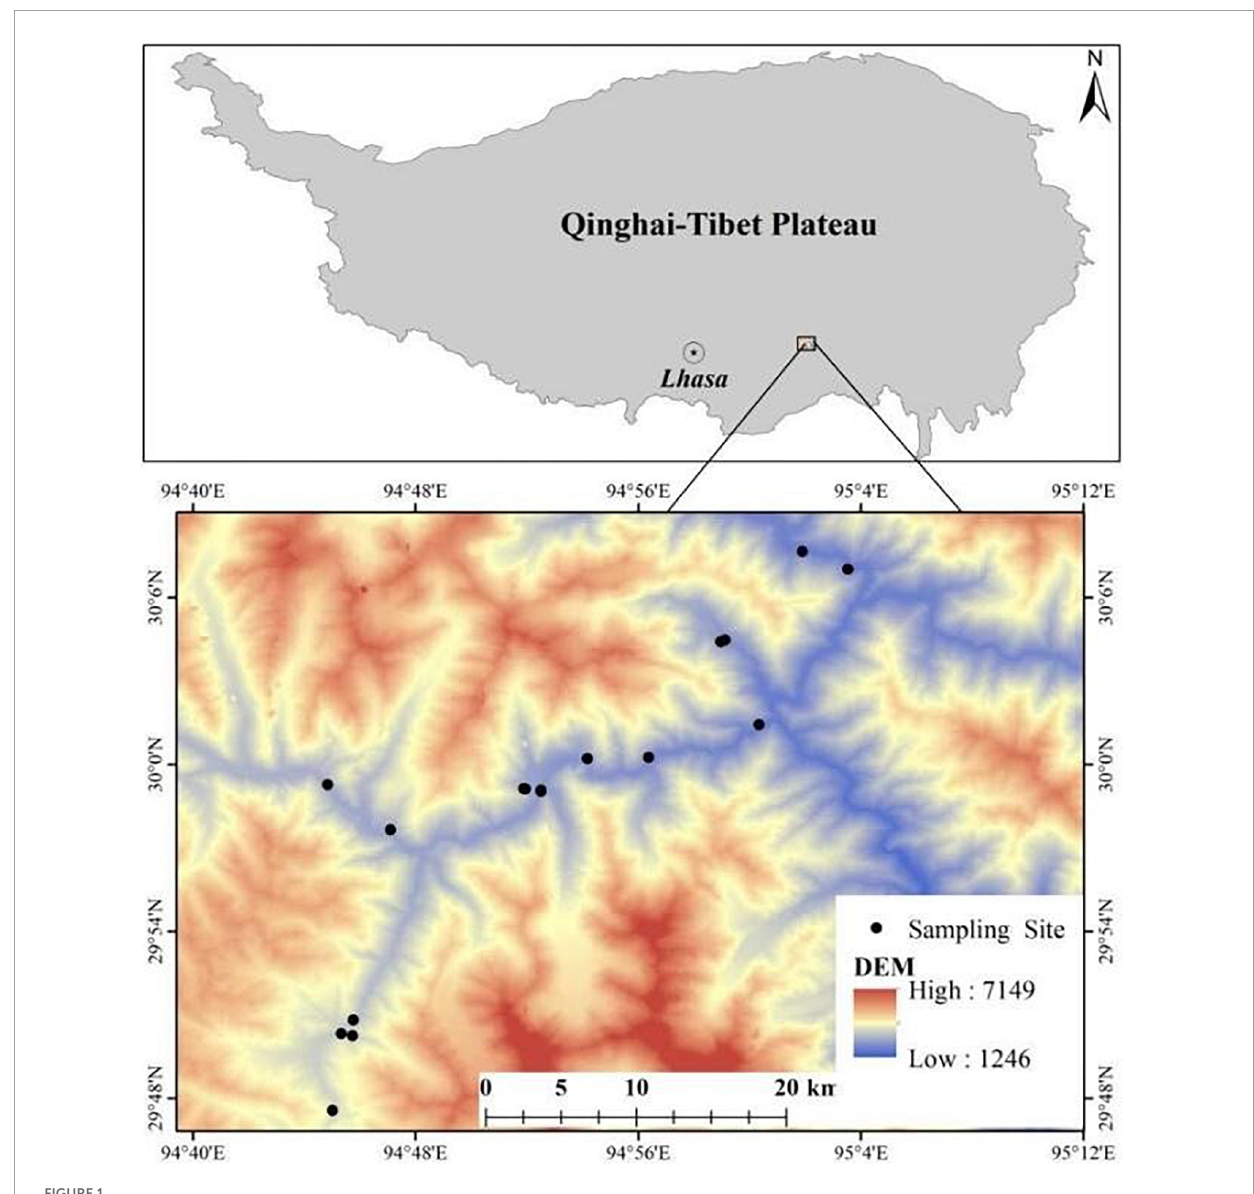
FIGURE1 Location of the study area and distribution of soil sampling points.